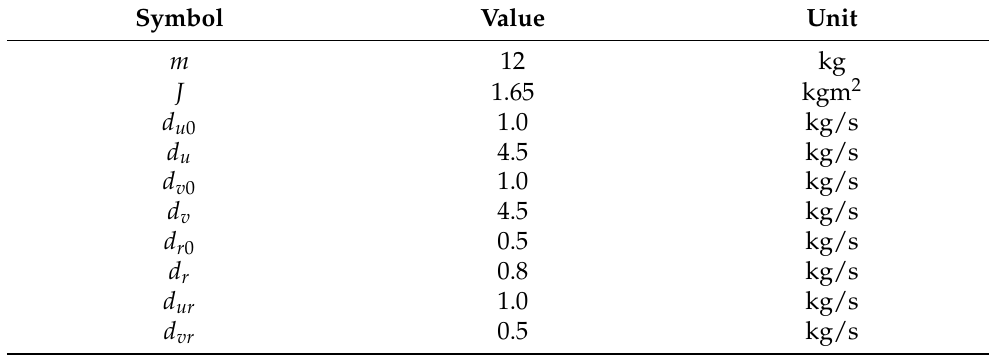
Table 1. Parameters of